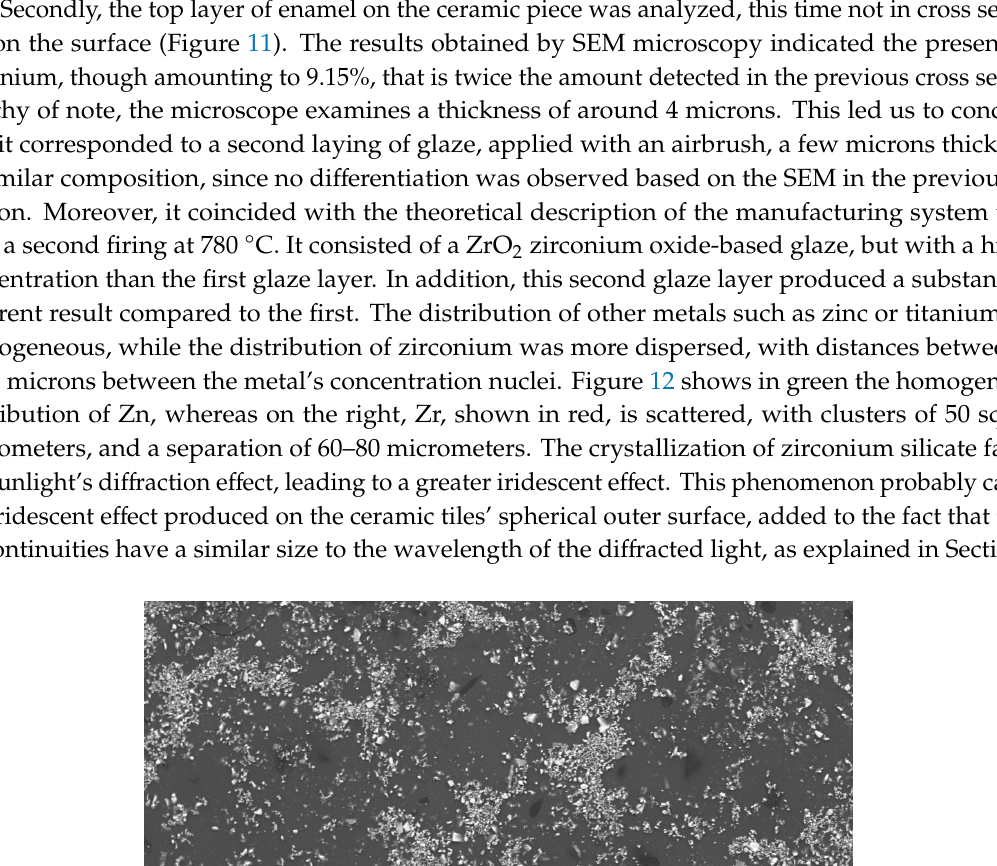
Figure 10. Energy Dispersive X-ray Spectrometer (EDS) of the section of the first layer of ZrO 2 glaze.